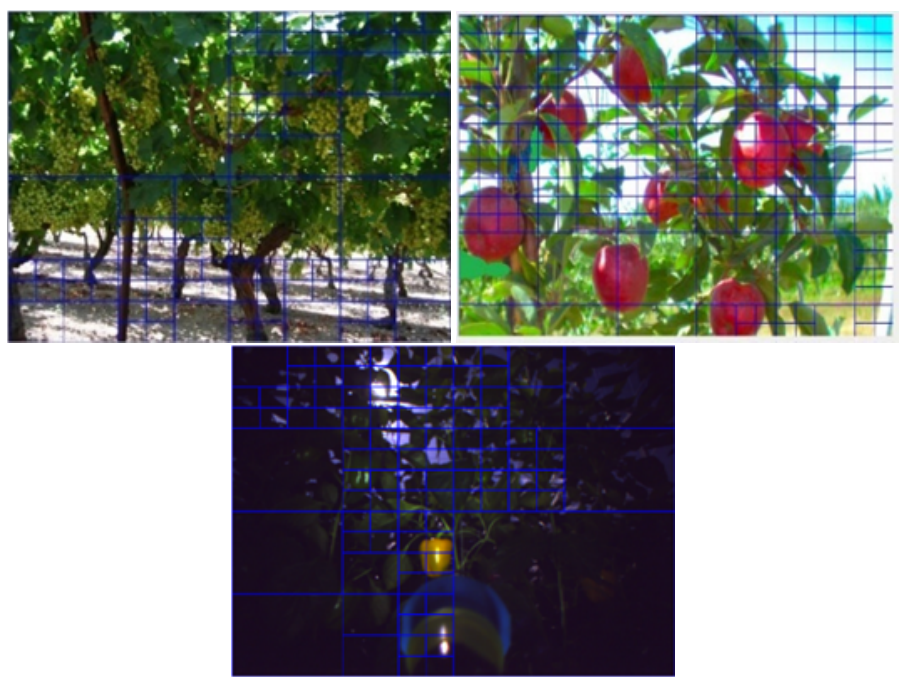
Figure 5. Image split into sub-images: